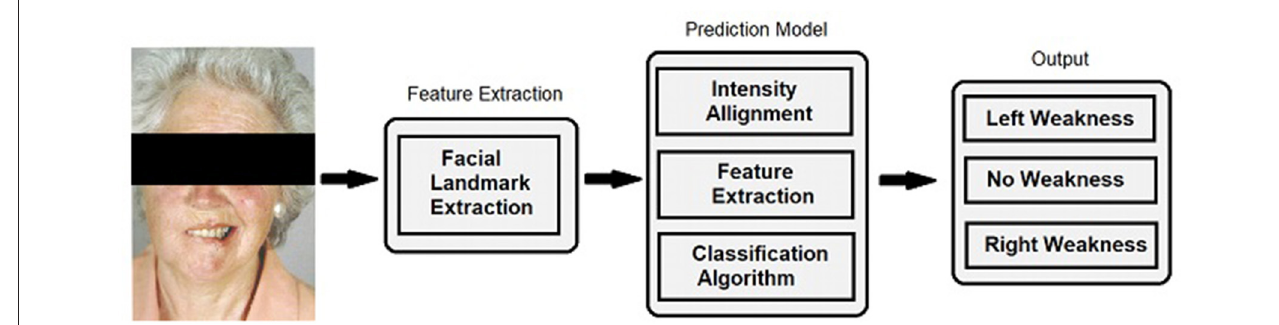
FIGURE 1 | Facial landmark extraction and classification. For algorithm training and performance, videos were decomposed into individual frames and facial landmarks were extracted. Normalization was performed by aligning the extracted landmarks of current input sequences to a template to handle different head scales, location, and orientation. The same transformation was applied to the pixel intensity information to remove these variations. A predictive model computed the classification result for each individual frame and a voting classifier reduced the output into discrete classifications comprised of no weakness, left facial weakness, and right facial weakness